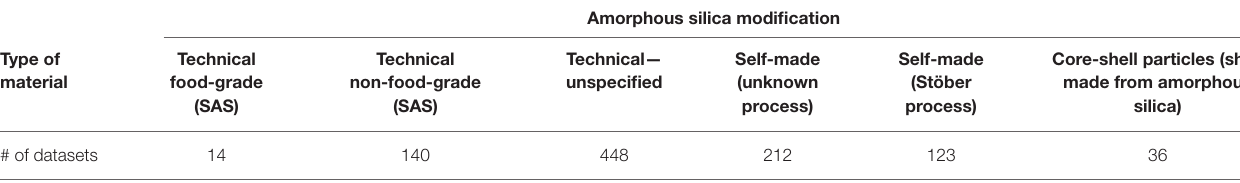
TABLE 1 | Modifications of amorphous silica used in the 316 selected studies.